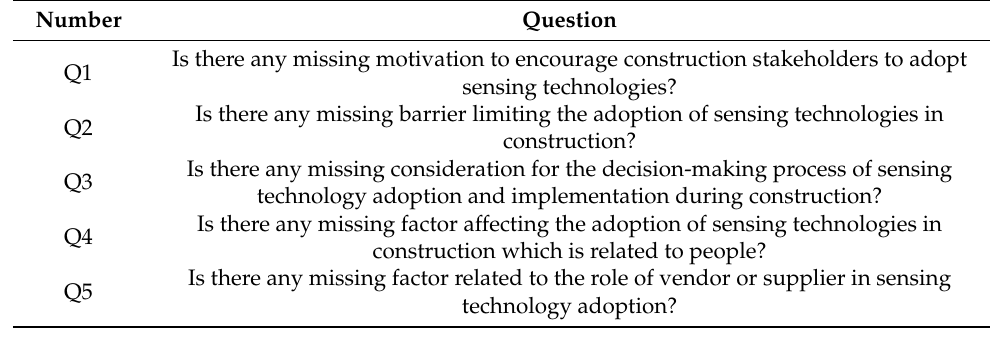
Table 8. Questions for evaluation the proposed governance framework.